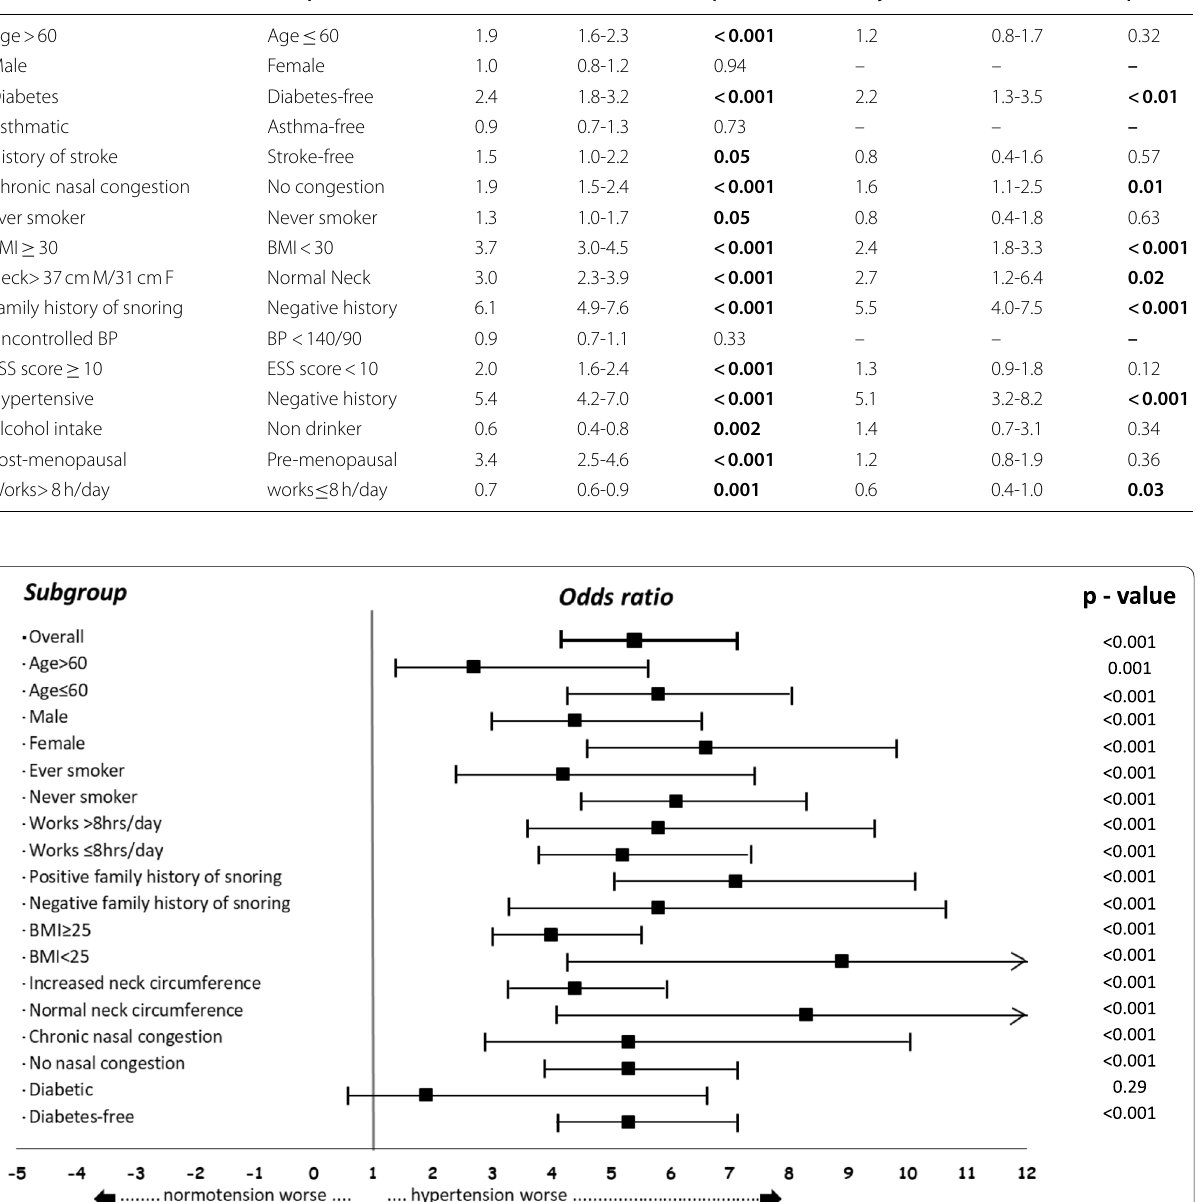
OSA increases 6-fold for every 10% weight gain (Pep - pard et al. 2000b). Conversely, a 10-15% reduction in body weight has been shown to reduce OSA severity by 50% (Nousseir 2019). Our findings similar to majority of previ- ous studies imply that excessive body weight is the strong- est modifiable risk factor for OSA.